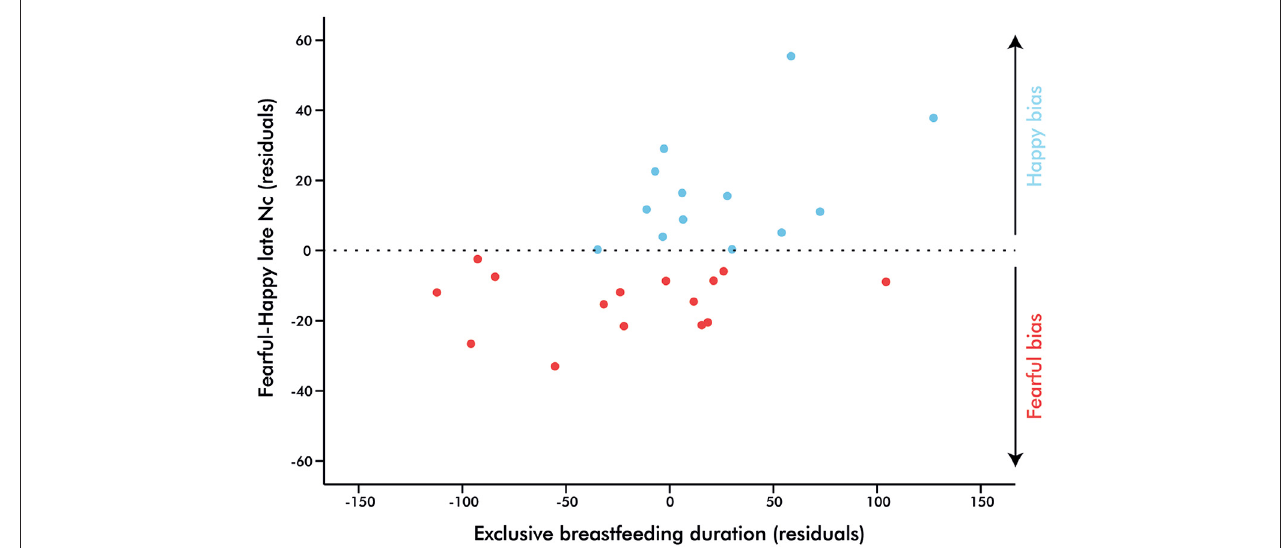
towards happy stimuli, while points below zero represent a bias towards fear as indexed by the right fronto-central Nc (700–800 ms), p = 0.01.